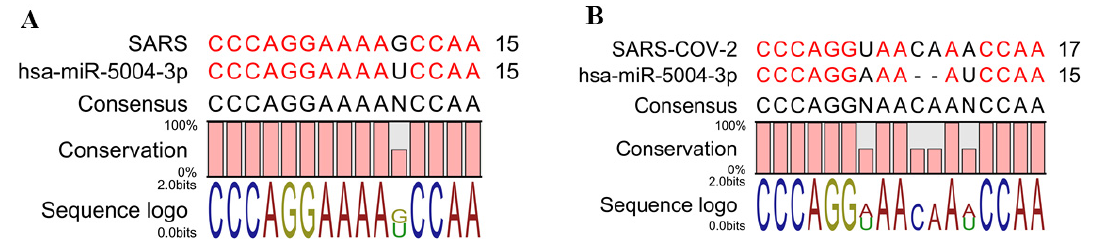
Figure 5. A two-nucleotide insertion mutation in the leader sequence of SARS-COV-2 results in lower binding between the Figure 5. A two − nucleotide insertion mutation in the leader sequence of SARS − COV − 2 results in lower binding between viral leader sequence and seed region of hsa-miR-5004-3p. ( A ) Alignment of hsa-miR-5004-3p with SARS. ( B ) Alignment of the viral leader sequence and seed region of hsa − MIR − 5004 − 3p. ( A ) Alignment of hsa − miR − 5004 − 3p with SARS. ( B ) Align- hsa-miR-5004-3p with ment of hsa − miR − 5004 − 3p with SARS − CoV − 2.